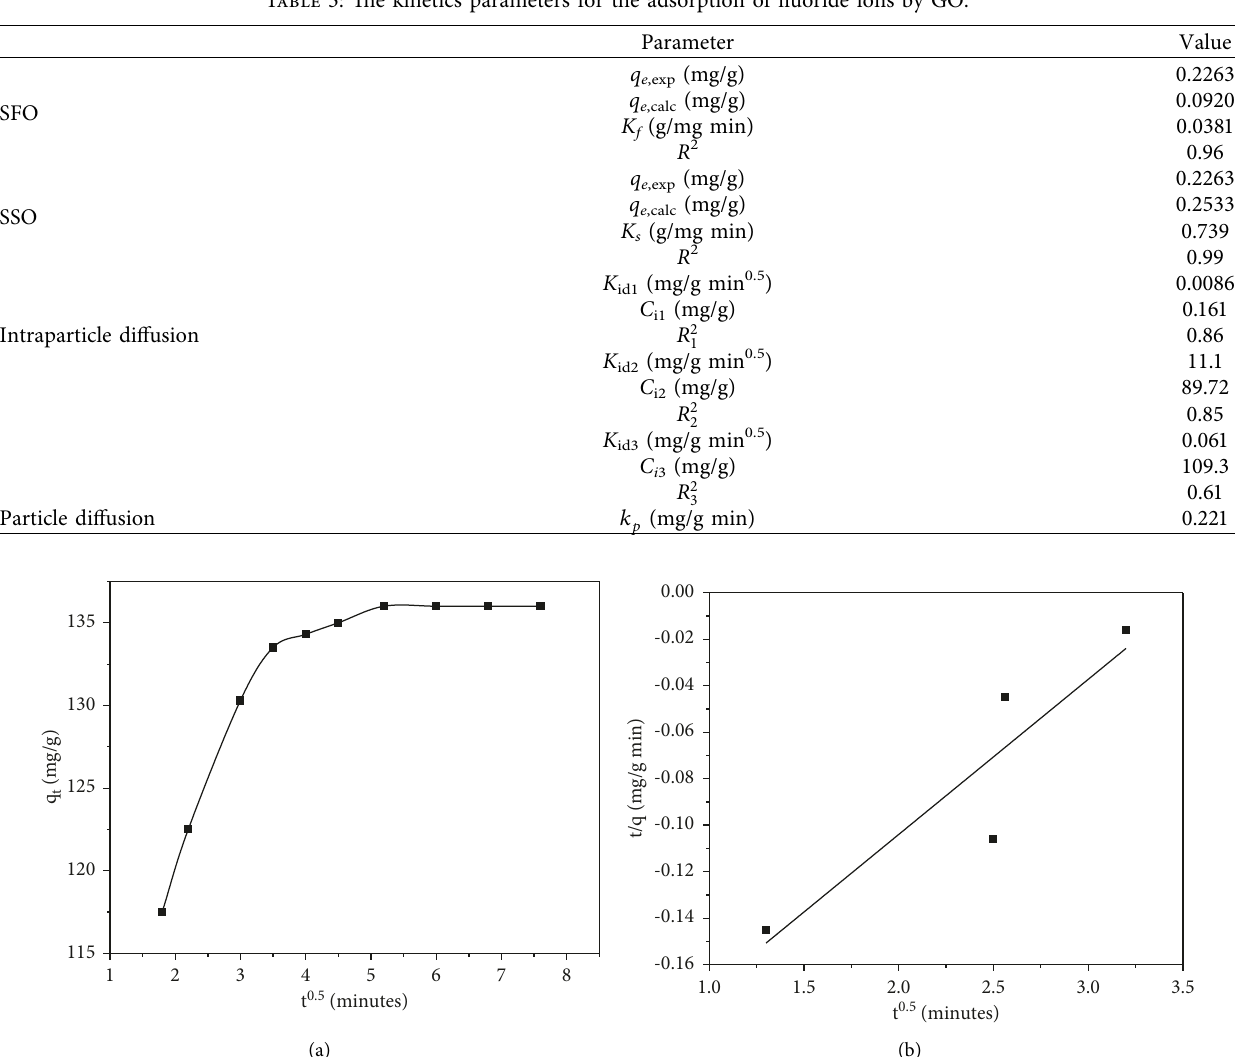
Figure 13: A plot for (a) Weber and Morris, (b)